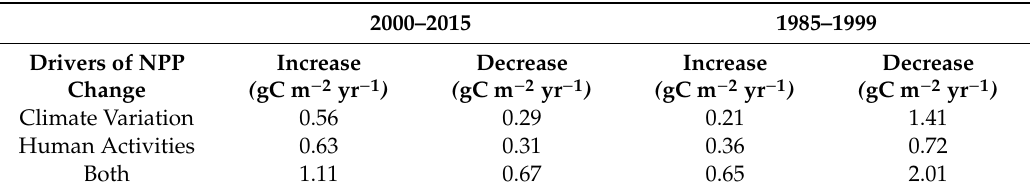
Table 5. Statistics of the NPP dynamics for the base and restoration periods.